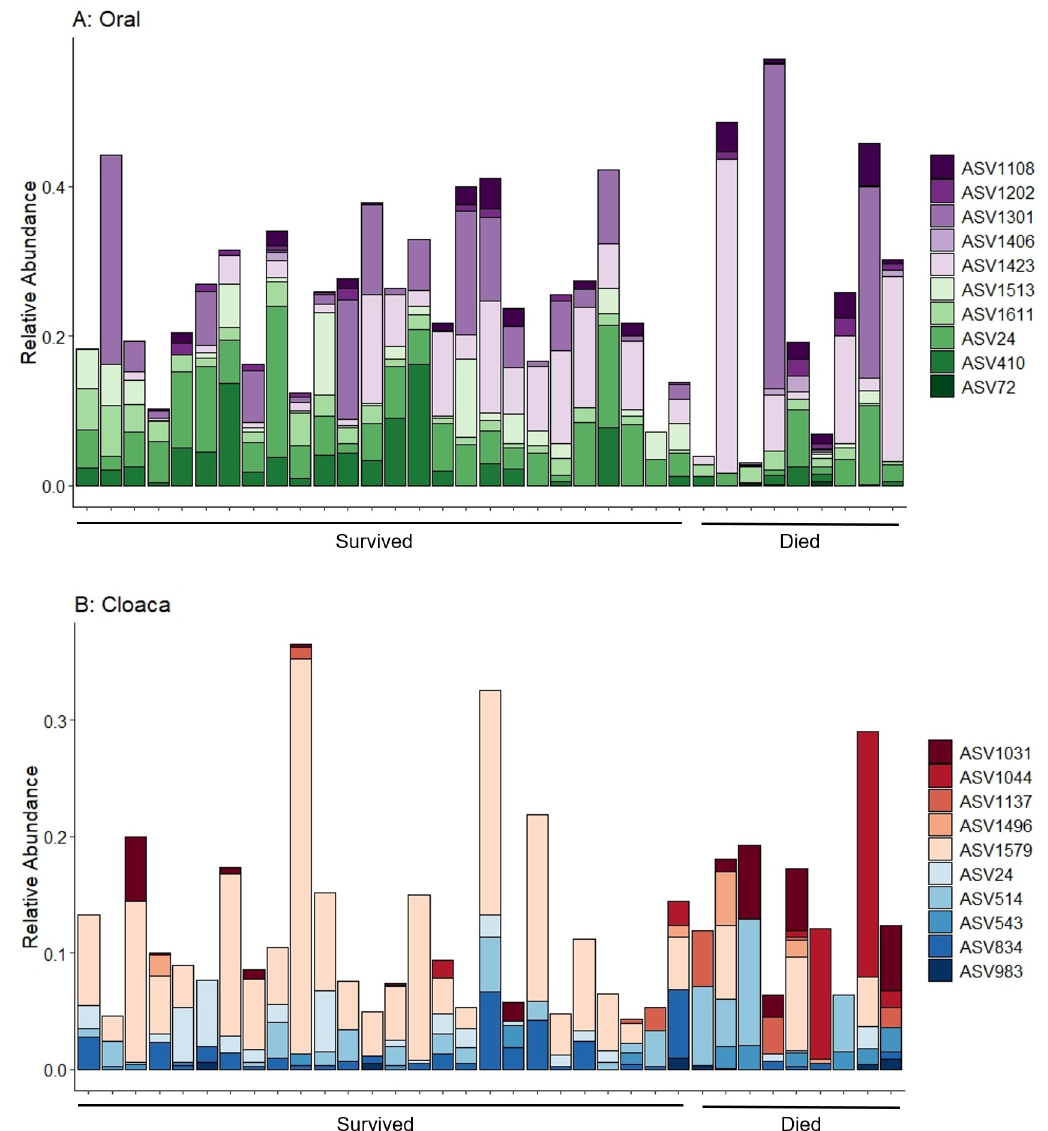
Fig 3. Random forest model predictions for survival. The 10 most significant ASVs at intake that differ between turtles that survived and those that died for oral samples (A) and cloacal samples (B). Taxonomy information for these ASVs is provided in Table